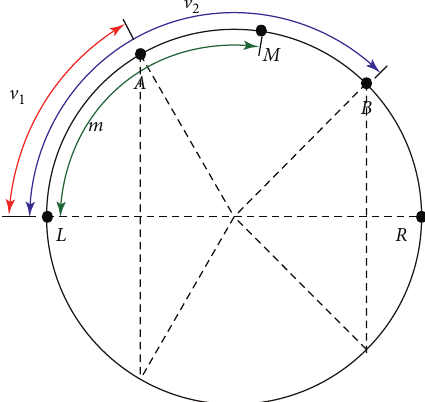
Figure 1: The Salop circular market with attribute